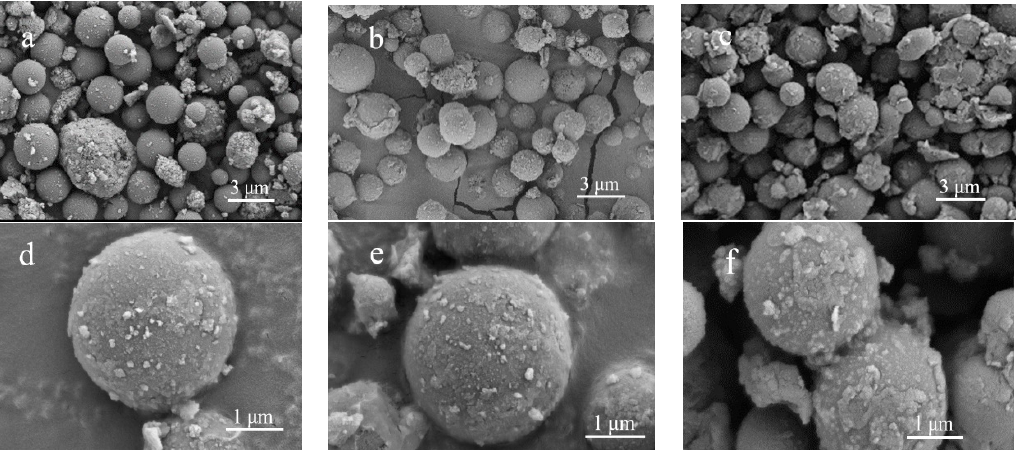
Figure 6. SEM results of pigments with different ratios of binder and nano TiO 2 . ( a , b ) 1:2; ( c , d ) 1:1; ( e , f ) 2:1.